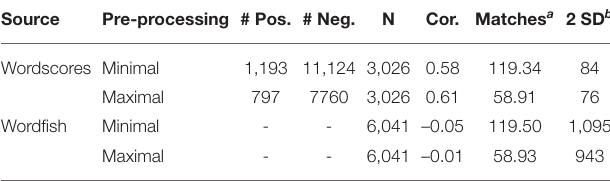
TABLE 5 | Characteristics and results for supervised and unsupervised Methods. Source Pre-processing # Pos. #